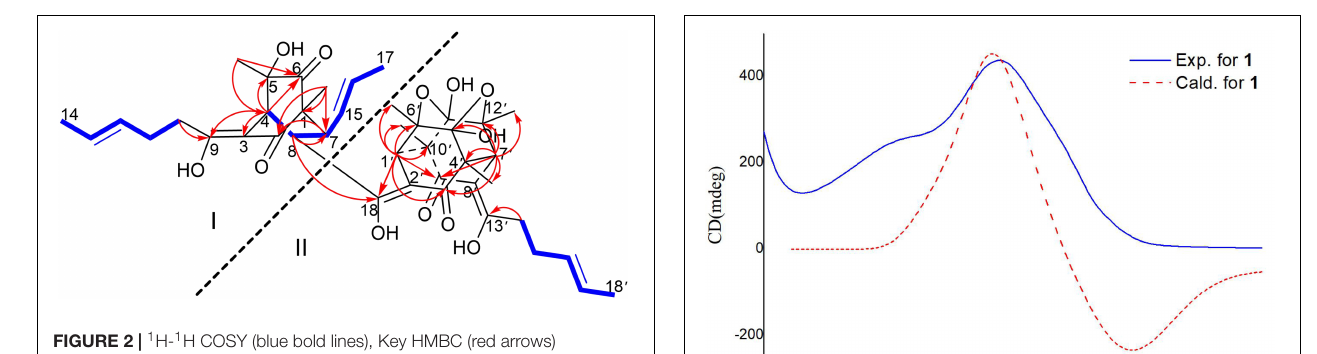
FIGURE 2 | 1 H- 1 H COSY (blue bold lines), Key HMBC (red arrows) correlations of trisorbicillinone E ( 1 ).